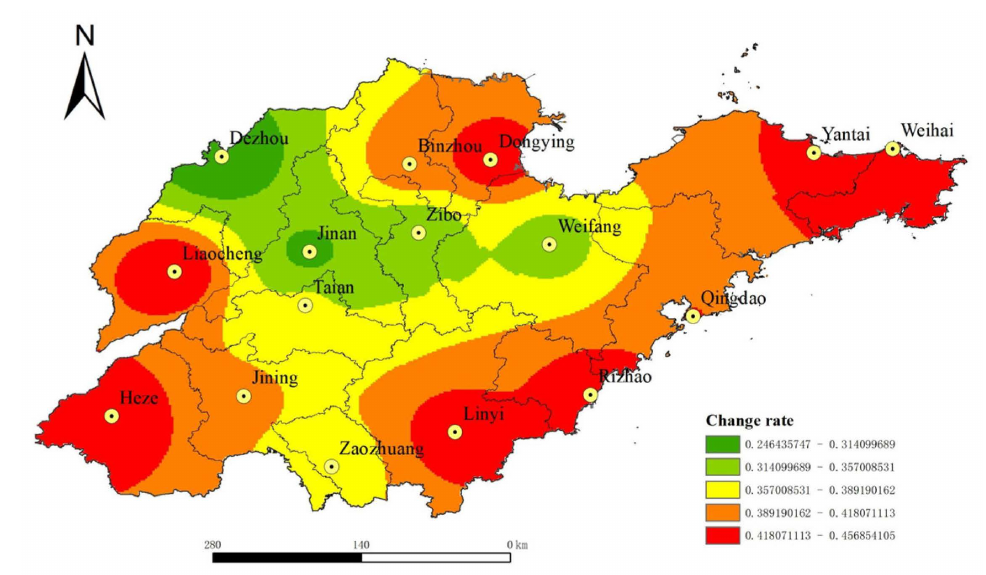
Figure 6. Spatial difference in land traffic accessibility change rate in Shandong Province, China